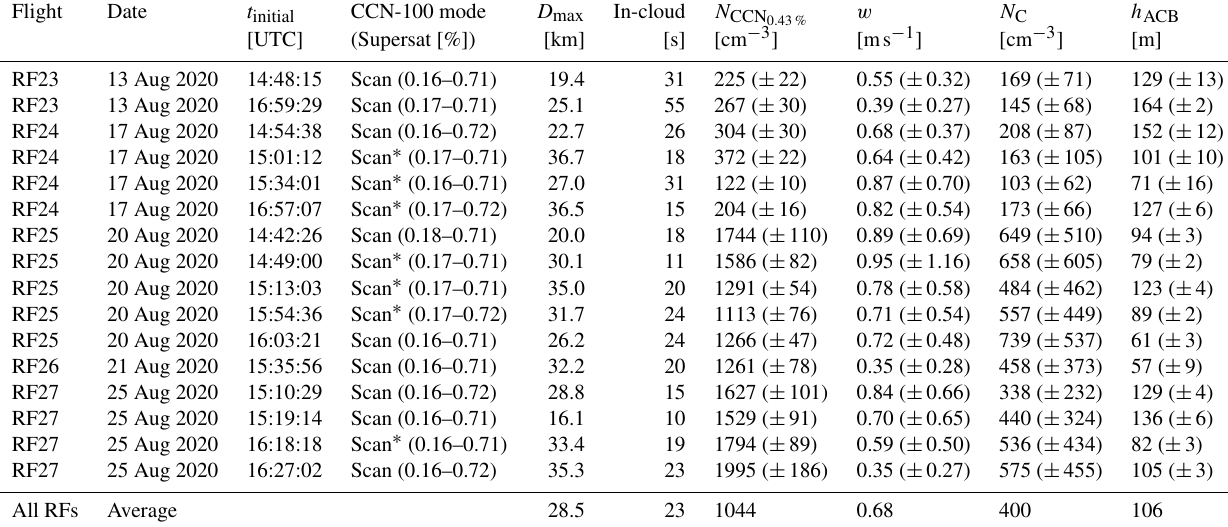
Table 2. All pairs consisting of serial below-cloud-base (BCB) and above-cloud-base (ACB) legs during the August 2020 deployment. Mean values and standard deviation in parentheses for w and N C from ACB cloud portions and N CCN maximal distance of cloud measurements to the aerosol measurements, and h ACB is the height above cloud base with standard deviation in parentheses.